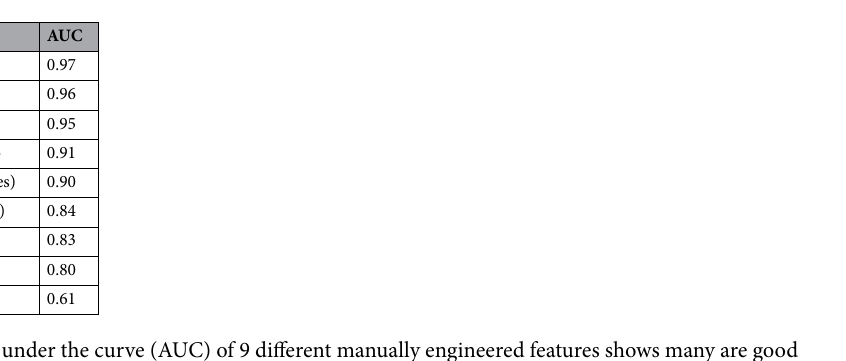
Table 1. The area under the curve (AUC) of 9 different manually engineered features shows many are good predictors of cell phenotype.